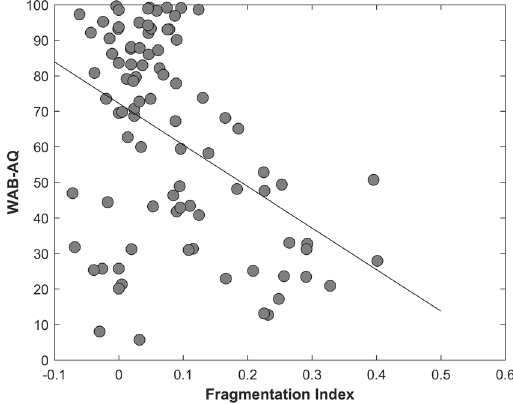
Figure 4. Correlation between Fragmentation index and aphasia severity (r = − 0.4302, p <